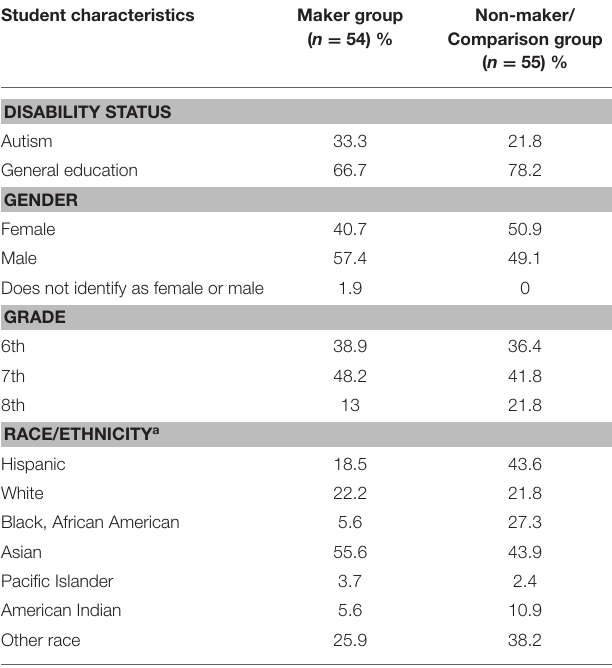
TABLE 1 | Frequency of demographic characteristics among students in intervention and comparison groups. Student